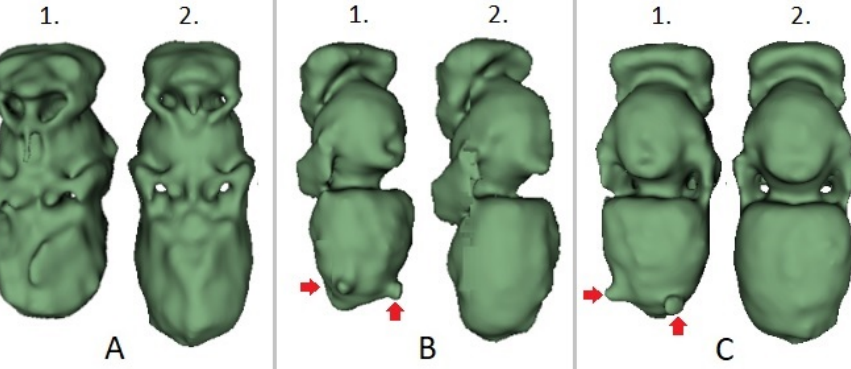
Figure 3. Computer-based three-dimensional reconstructions of honey bee pupae located beside each other in the comb. 1: parasitized by V. destructor , 2: intact; ( A ): ventral, ( B ): lateral, ( C ): dorsal views. Mites are marked by red